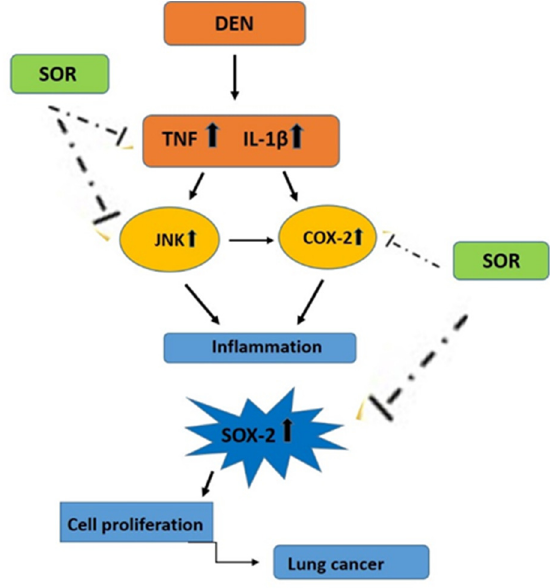
Figure 8. Role of SOR as a potential anticancer agent in lung carcinogenesis via targeting JNK/COX-2 related SOX-2 signaling pathway.